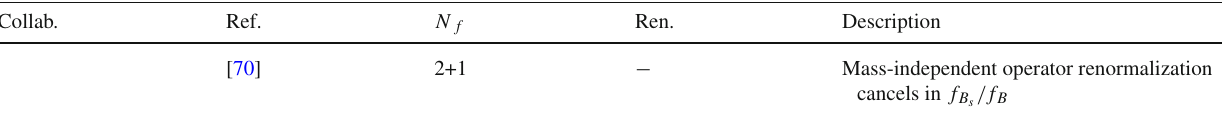
Table 145 Description of the renormalization/matching procedure adopted in the determinations of the B - and B s -meson decay constants for N f = 2 + 1 simulations Collab.